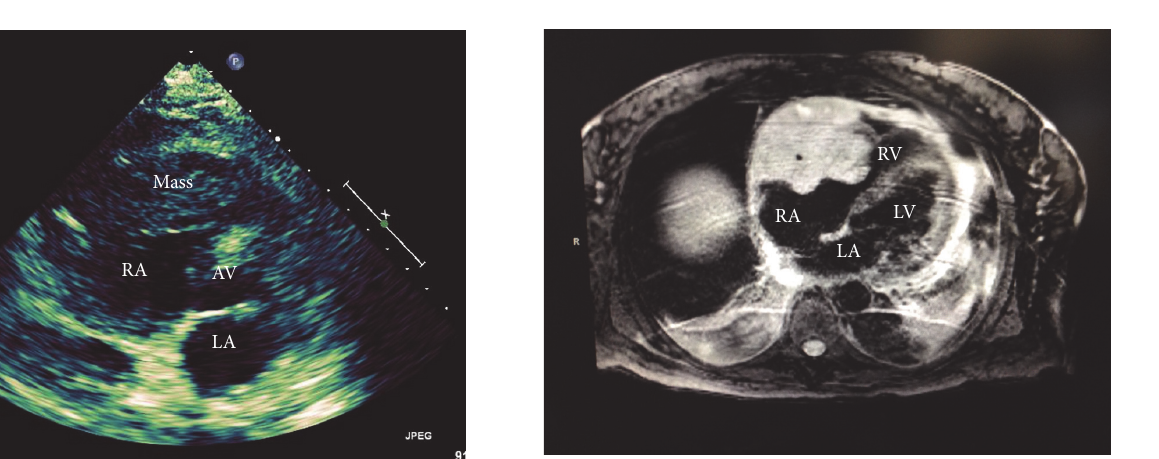
Figure 1: Technically difficult, parasternal short axis view at the aortic valve level showing a large heterogeneous mass occupying a majority of the RVOT.